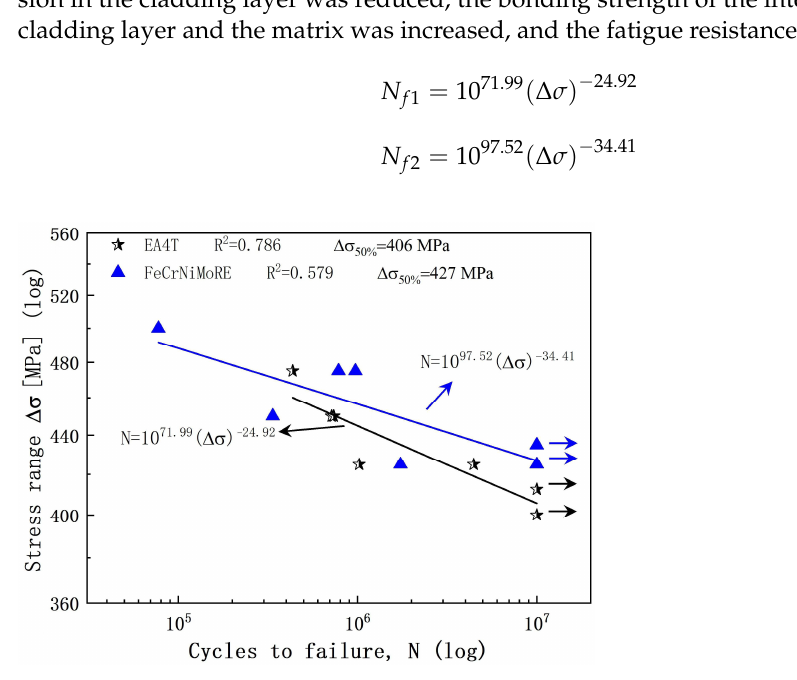
Figure 14. Gradient curve for the properties of the cladding cross-section.